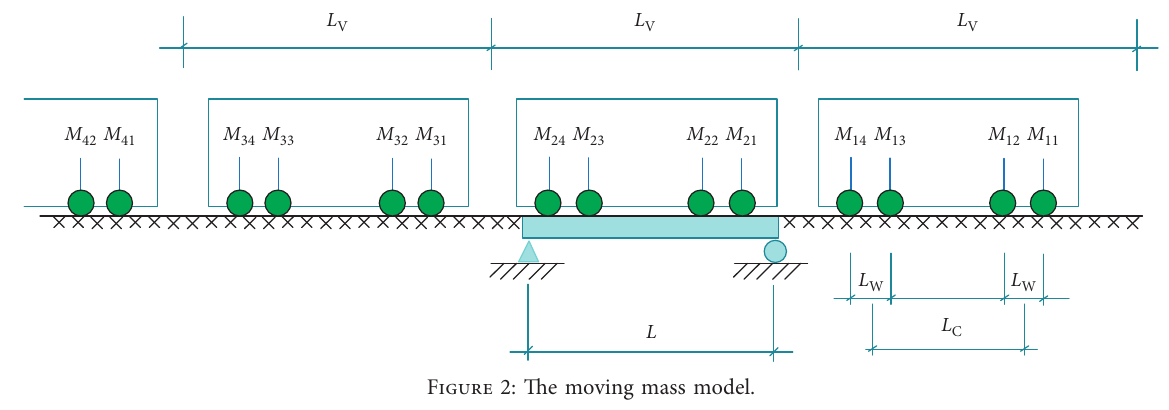
Figure 2: The moving mass